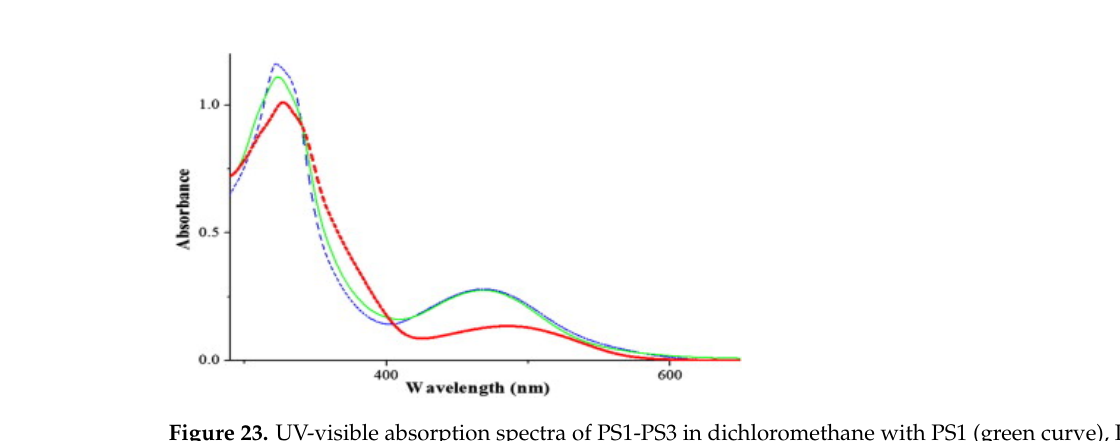
Figure 23. UV-visible absorption spectra of PS1-PS3 in dichloromethane with PS1 (green curve), PS2 (blue curve), and PS3 (red curve). Reprinted from Ref. [237] , Copyright 2013, Elsevier. In 2013, Lalevée and coworkers investigated another thiophene derivative, i.e., QXTP and the polymeric PQXTP (See Figure 24) [238]. By extending the π -conjugation in PQXTP, a redshift of the absorption was obtained (See Figure 25).